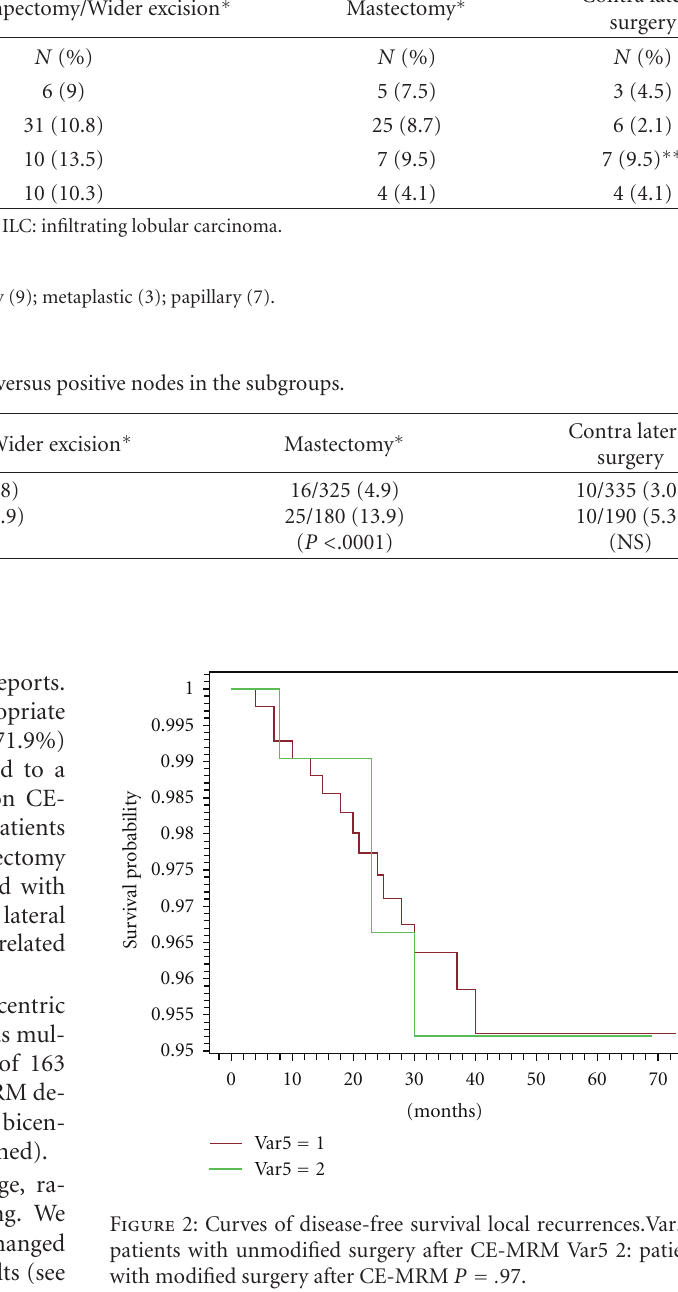
Figure 2: Curves of disease-free survival local recurrences.Var5 1: patients with unmodified surgery after CE-MRM Var5 2: patients with modified surgery after CE-MRM P = .